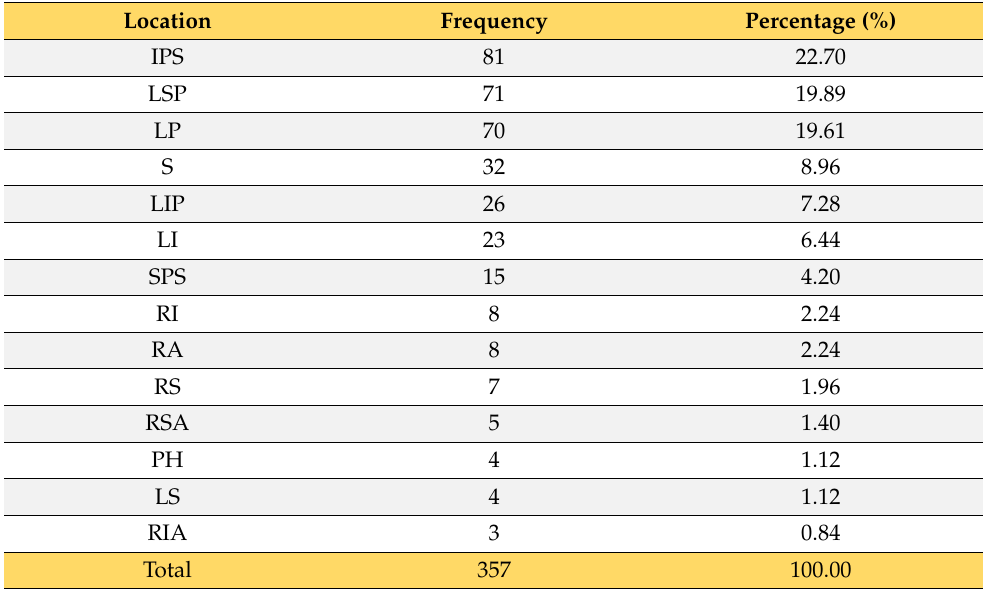
Table 3. The frequency and percentage of each bypass tract location ( n =